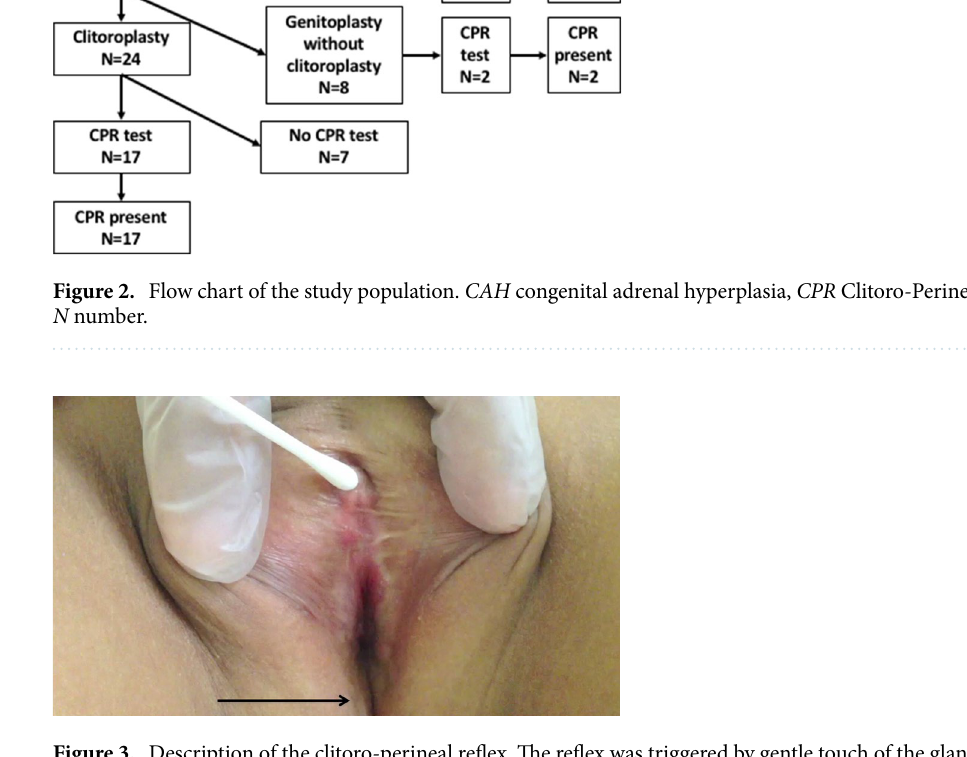
who underwent feminizing genitoplasty (vestibuloplasty and vaginoplasty) without reduction clitoroplasty, and; Group 3, children managed medically without any surgery.